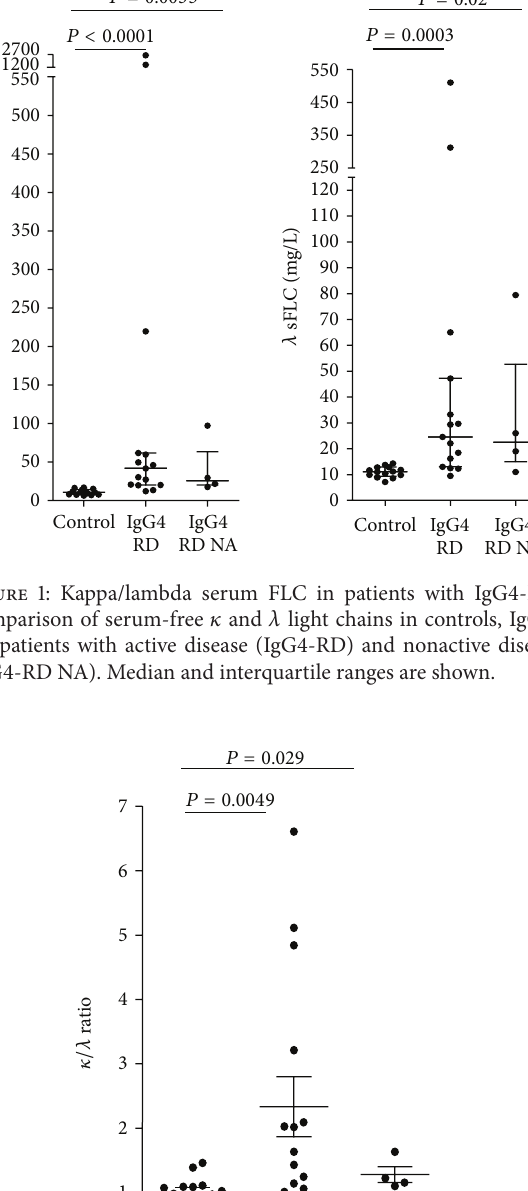
between the IgG4 levels and either 𝜅 sFLC ( 𝑃 = 0.21 , Spear- man 𝑟 = 0.21 ) or 𝜆 sFLC ( 𝑃 = 0.25 , Spearman 𝑟 = 0.3 ) levels. There was a correlation of total IgG levels with 𝜅 sFLC ( 𝑃 = 0.006 , Spearman 𝑟 = 0.67 ) but not with 𝜆 sFLC ( 𝑃 = 0.3 , Spearman 𝑟 = 0.27